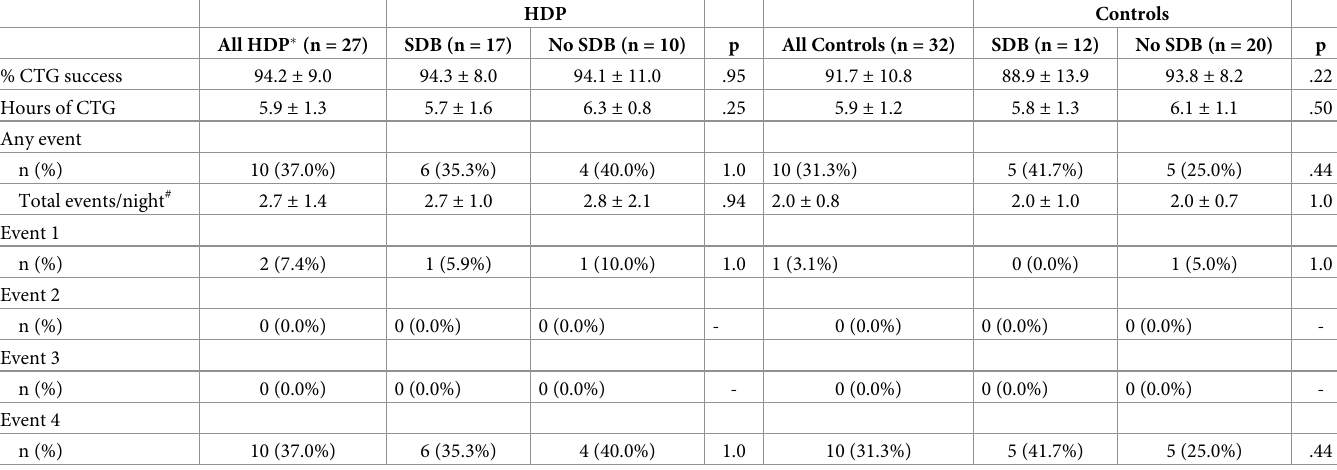
Table 2. Cardiotocography variables for hypertensive disorders of pregnancy cases and normotensive controls stratified by SDB.